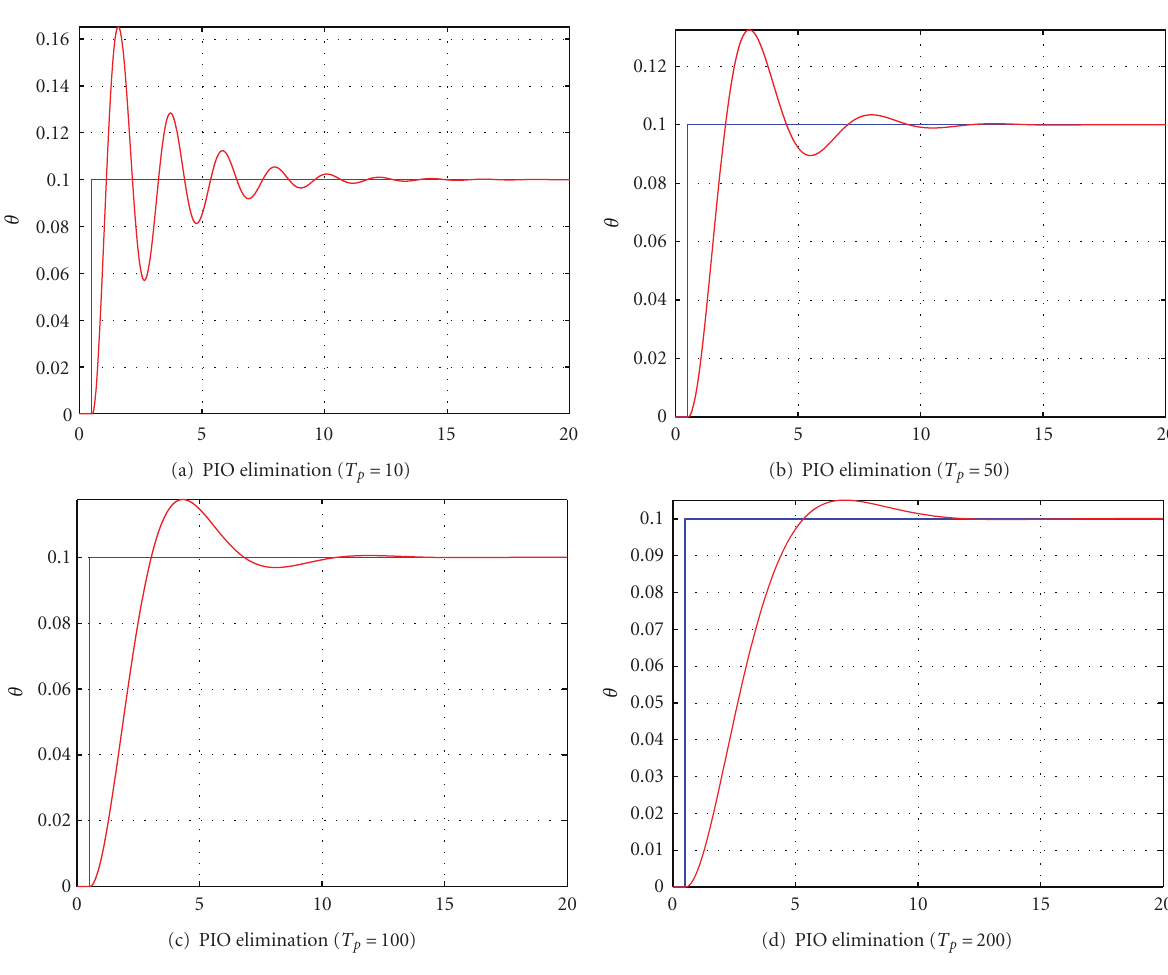
Figure 7: PIO elimination with di ff erent desired